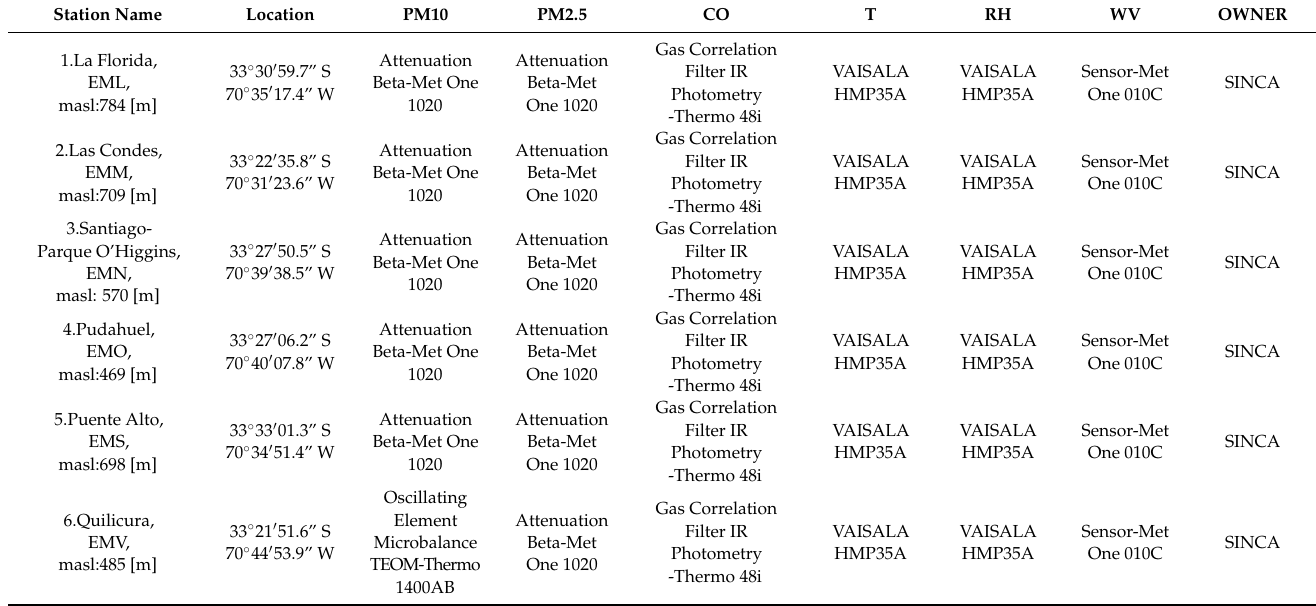
Table 1. The continuous recording of the variables in this study is carried out at 2 [m] above the ground in all sensors, with the exception of the one measuring the magnitude of wind speed, which is at 10 [m] [37].